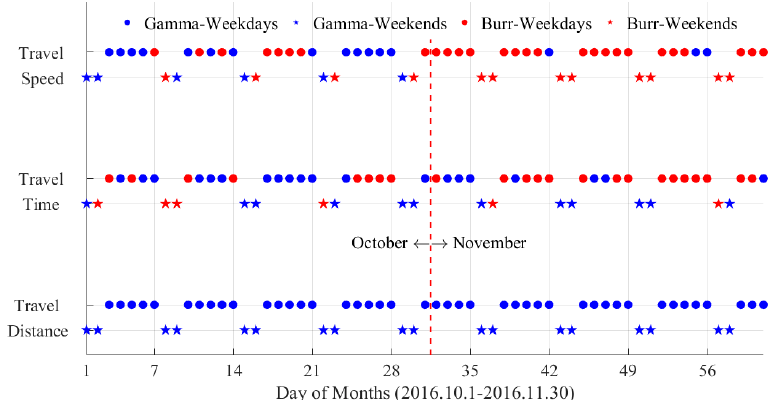
Figure 4. Best-fit distribution of daily trip metrics for 61 days.